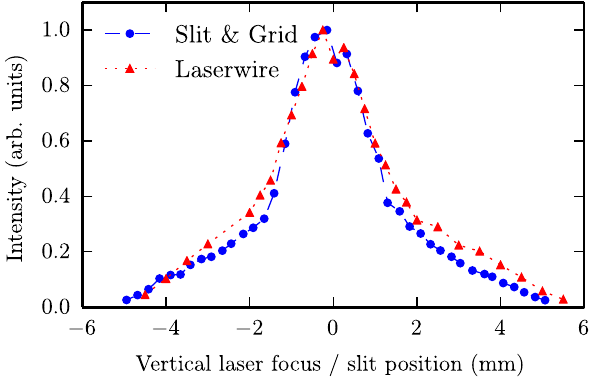
FIG. 13. Vertical profile of the H − beam measured by laserwire (dotted curve) and slit and grid (dashed curve)